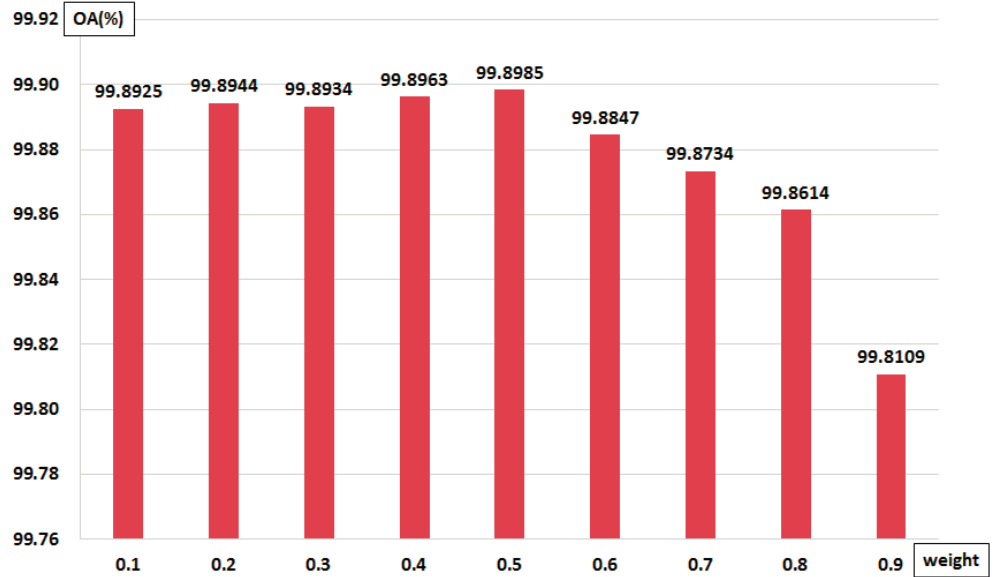
Figure 4. Comparison of OA performance according to the changes of weight for Equation